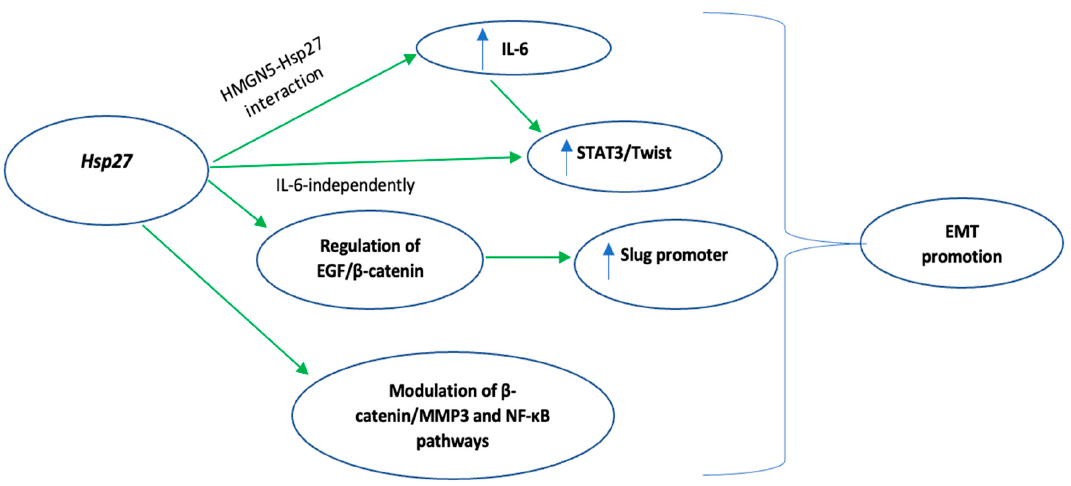
Figure 2. Summary of the molecular mechanisms of Hsp27-mediated promotion of Epithelial-mesenchymal transition (EMT). Green indicates activation. Key: EMT, epithelial to mesenchymal transition; EGF, epidermal growth factor; STAT3, signal transducer and activator of transcription 3; NF-kb, nuclear factor kappa-light-chain-enhancer of activated B cells; IL-6, interleukin 6.